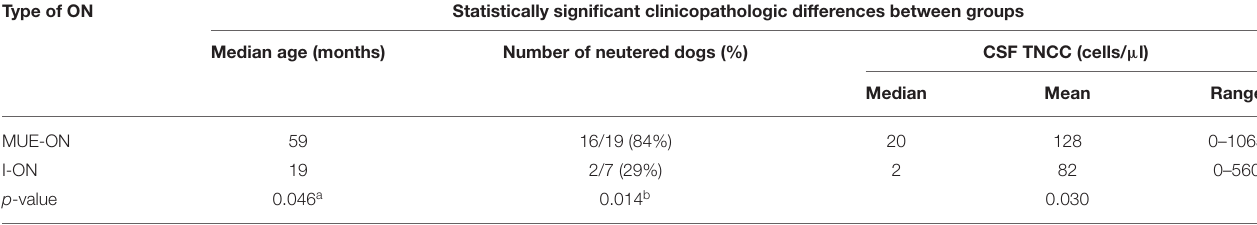
TABLE 2 | Comparison of statistically significant clinicopathologic differences between dogs with MUE-ON and I-ON. Type of ON Statistically significant clinicopathologic differences between groups Median age (months) Number of neutered dogs (%)